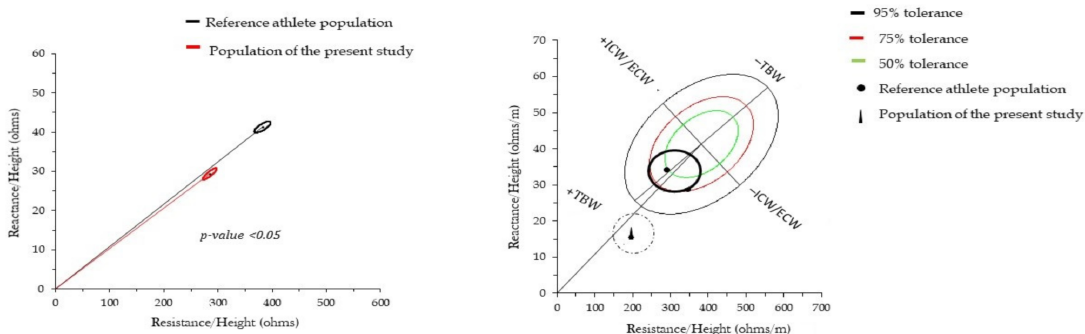
Figure 2. Although phase angle (PhA) was directly associated with the standing long jump (SLJ) (R 2 = 0.272, p < 0.001) in the crude model, this association was statistically non-significant after adjusting for age, LSTM, and body fat (BF) (R 2 = 0.531, p = 0.109). In addition, the PhA was directly associated with PS T-CAR (R 2 = 0.360, p < 0.001) in the crude and age-adjusted models, accounting for 70% of the variance in the PS T-CAR . PhA was not a significant explanatory variable of the PS T-CAR after adjusting for LSTM and BF (R 2 = 0.703, p = 0.169). PhA was inversely associated with the 10 m and 30 m sprint times in the crude and age, LSTM, and BF-adjusted models, accounting for 24% and 61% of the variability in 10 m and 30 m sprints time, respectively. PhA was also inversely associated with RSAmean and RSAbest times, in which the models composed by age, LSTM, and BF explained approximately 74% and 64% of the variability in these anaerobic physical performance components, respectively (Table 2). Table 2. Simple and multiple regression analysis outputs between phase angle and physical performance outcomes in young soccer players ( n = 62).